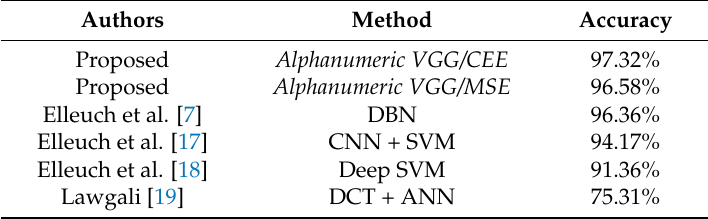
Table 8. Comparison with state-of-the-art methods on the HACDB database.